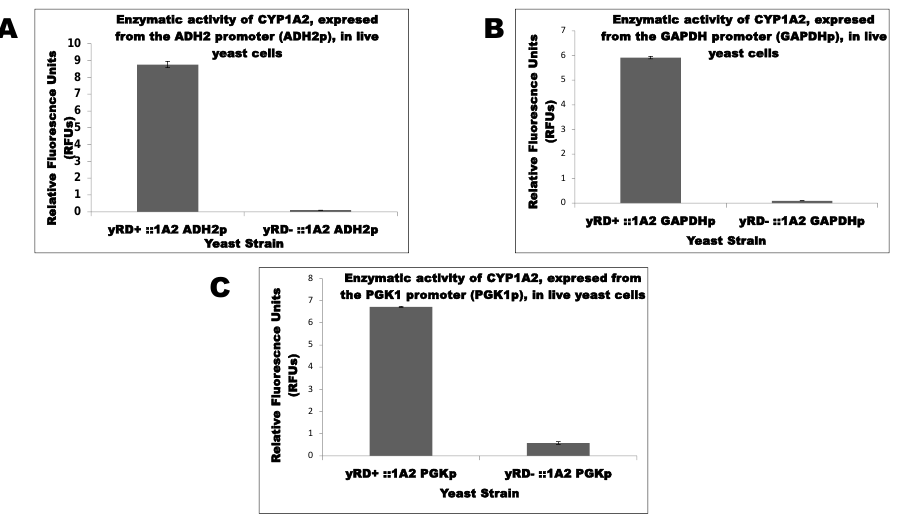
Figure 1. A yeast extract peptone dextrose (YPD) plate ( A ) and ( B ) containing the antibiotic aureobasidin selects for yRD − ( 1 ) aureobasidin-resistant cells ( A ), while plate B shows four independent sub-clones of yRD + ( 3 ) and yRD − :: Bax ( 2 ), which were streaked out on the plate. ( C ) Growth of Bax containing yeast cells (yRD − :: Bax) on minimal medium (S) agar plates, SD (containing dextrose / glucose) and SG (containing galactose). Cells grow on glucose but do not grow on galactose.